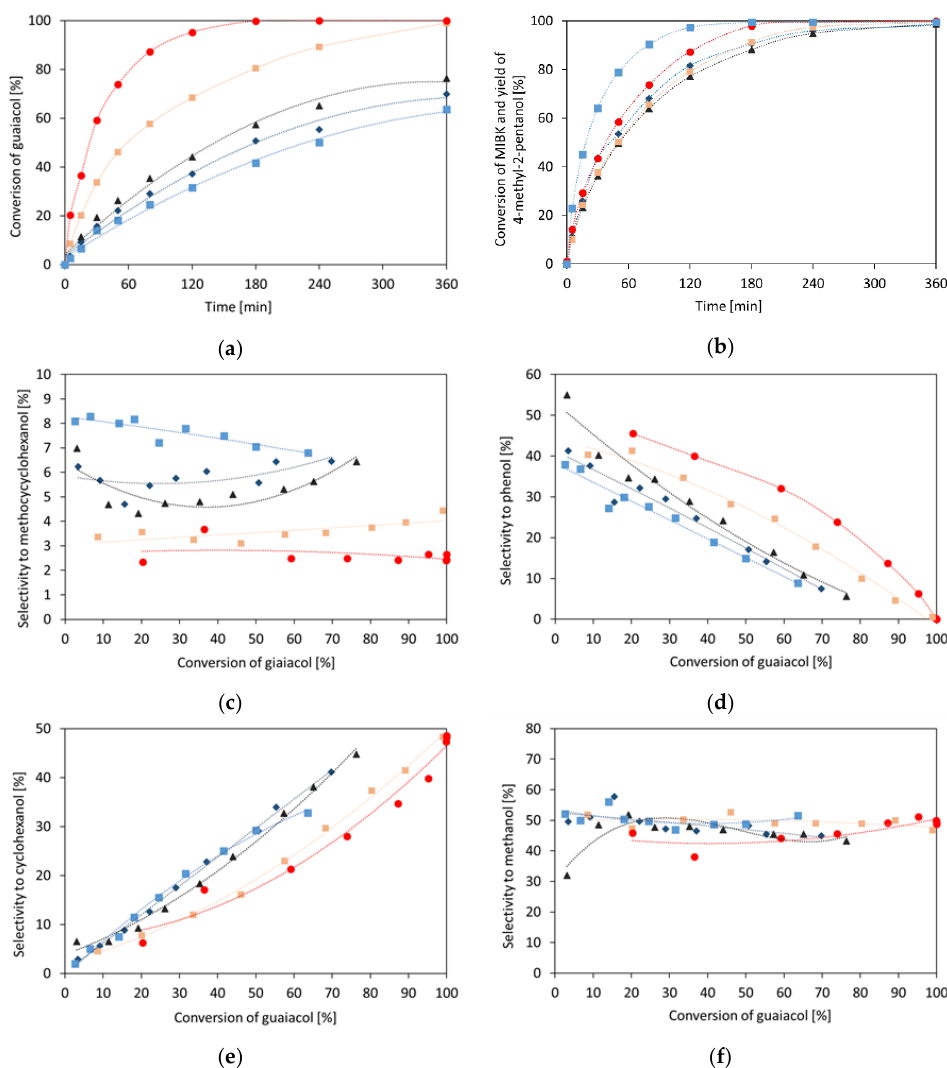
Figure 8. ( a ) Conversion of guaiacol; ( b ) Conversion of MIBK and yield of 4-methyl-2-pentanol. Selectivity to ( c ) methoxycyclohexanol, ( d ) phenol, ( e ) cyclohexanol, and ( f ) methanol at 70 °C in guaiacol:MIBK mixtures of 5:95, 20:80, 50:50, and 80:20 mol:mol as well as pure guaiacol and MIBK, marked with blue